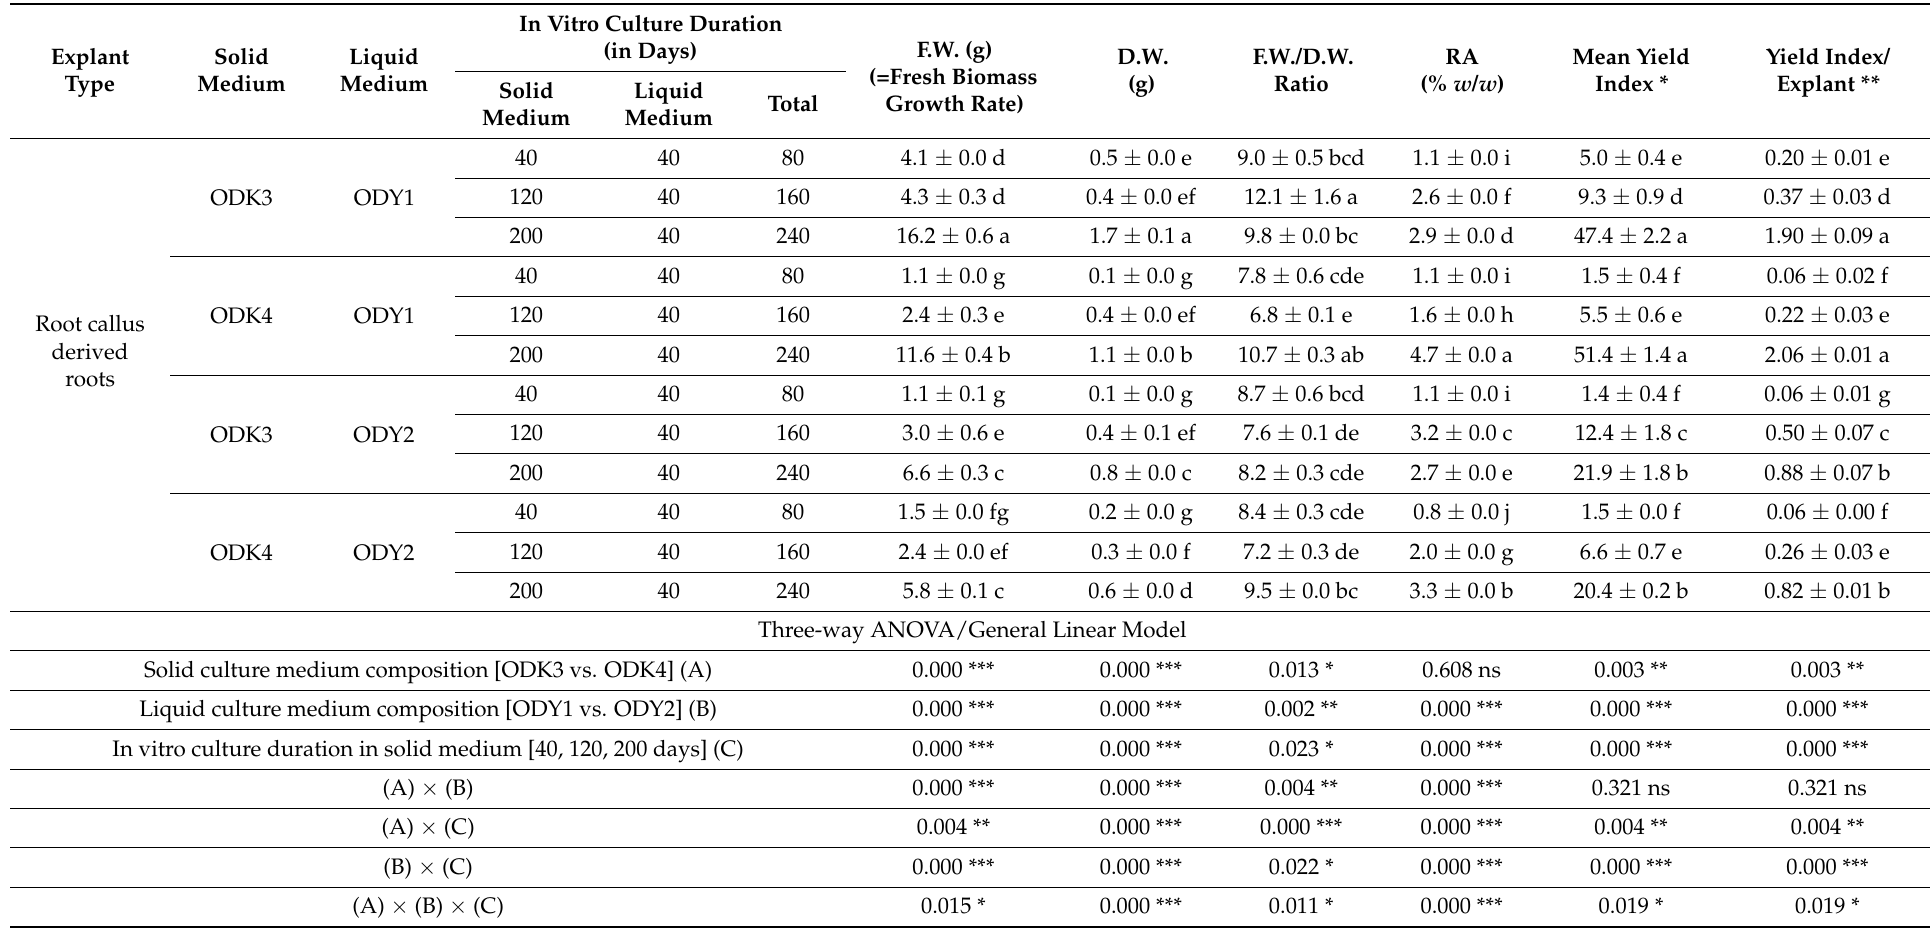
Table 3. Effect of media composition and combinations, and three incubation periods on biomass growth (FW, DW, FW/DW ratio), and RA production expressed